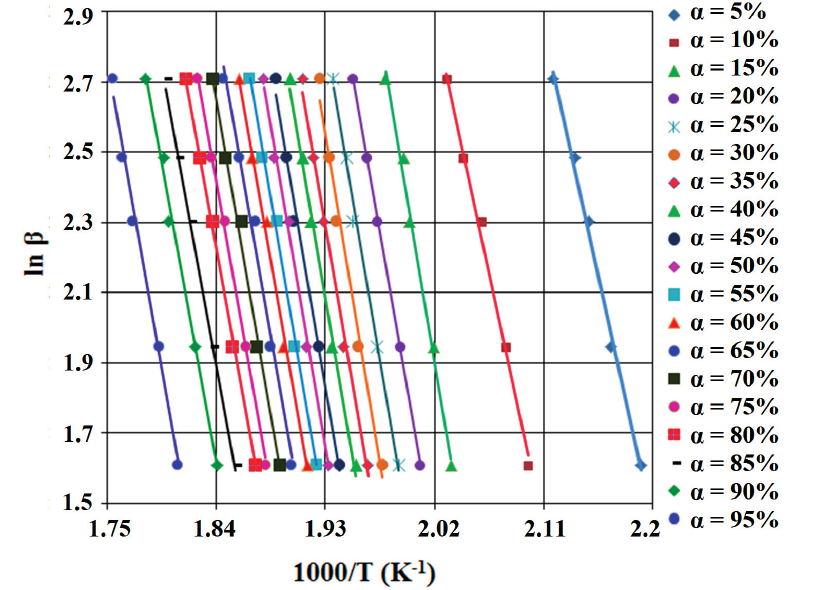
Figure 4. FWO (Flynn-Wall-Ozawa) diagram, for SB1 derivative.